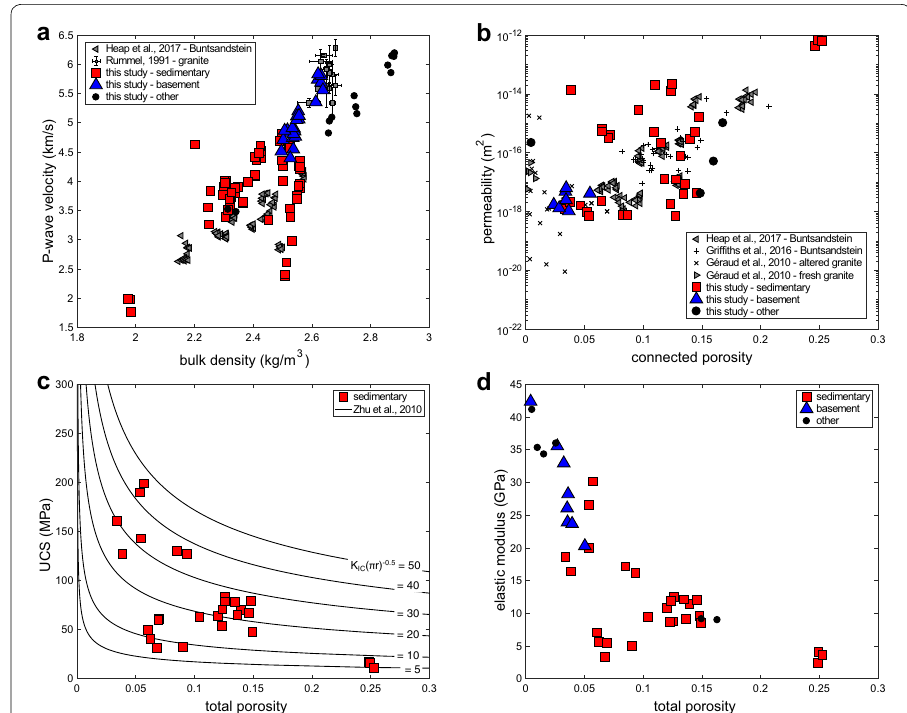
Fig. 8 a P-wave velocity as a function of bulk density. Grey triangles are data for Permo-Triassic sandstones from the EPS-1 exploratory borehole at Soultz-sous-Forêts, France (Heap et al. 2017); Grey squares are data for granites from the GPK-1 borehole at Soultz-sous-Forêts, France (Rummel 1992). Each square is the average value for a given depth and the error bars give the standard deviation. b Permeability as a function of connected porosity. We compare the data gathered in this study with data for the Permo-Triassic sandstones (Griffiths et al. 2016; Heap et al. 2017) and granites (Géraud et al. 2010) from the EPS-1 exploratory borehole at Soultz-sous-Forêts, France. c Uniaxial compressive strength of the sedimentary rocks investigated in the present study. Black curves—the analytical approximation of the pore-emanating crack model, as derived by Zhu et al. (2010). d Elastic modulus of the rocks investigated in the present study. The rocks from this study are categorised as either being sedimentary (red squares), from the crystalline basement (blue triangles), or as being other lithologies (black circles); see Table